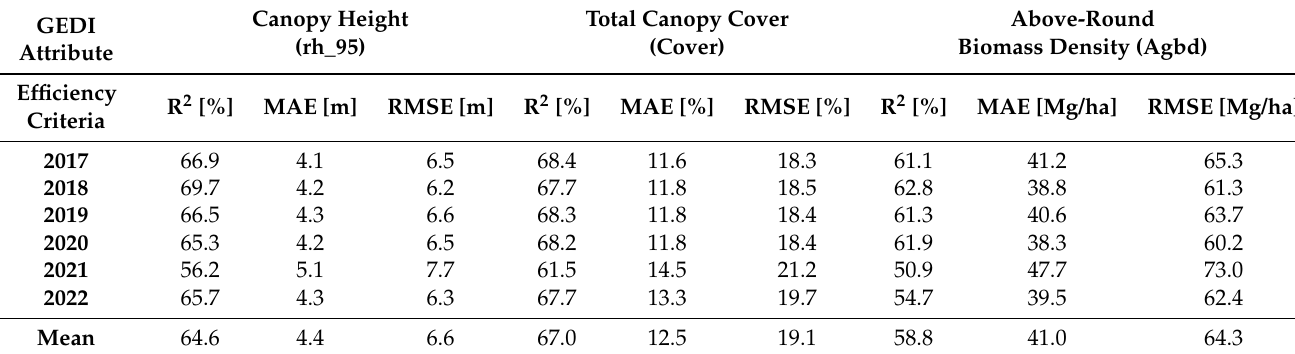
Table 2. Model accuracy assessment for the canopy height, total canopy cover and AGBD models of all years according to the coefficient of determination (R 2 ), Mean Absolute Error (MAE) and Root Mean Square Error